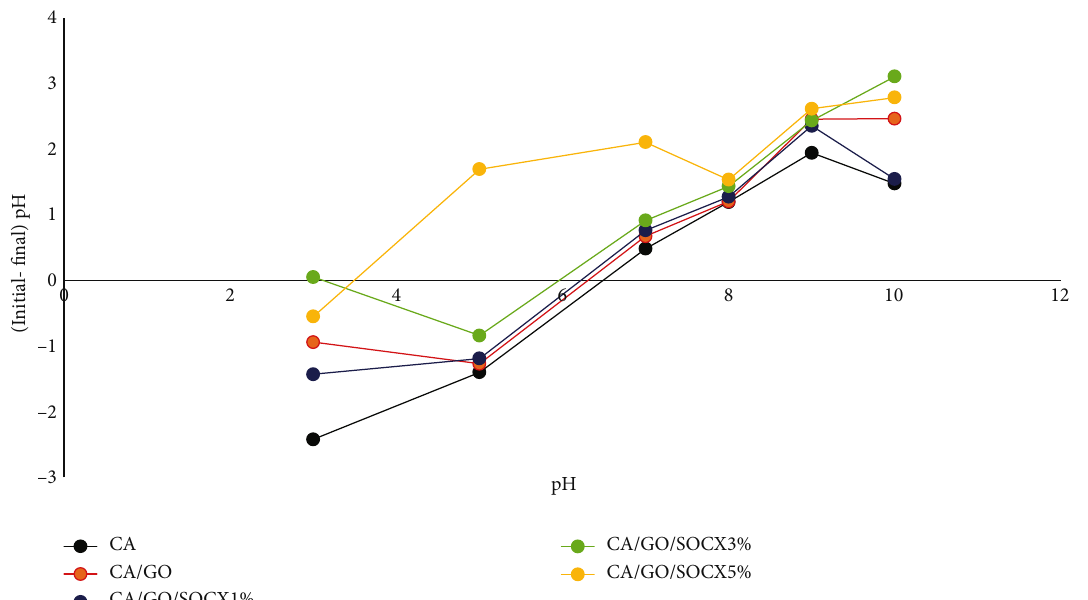
Figure 7: pH of point of zero charge (pH loading (1%, 3%, and 5%). Conditions for pH time with pH variation (3, 5, 7, 8, 9, and